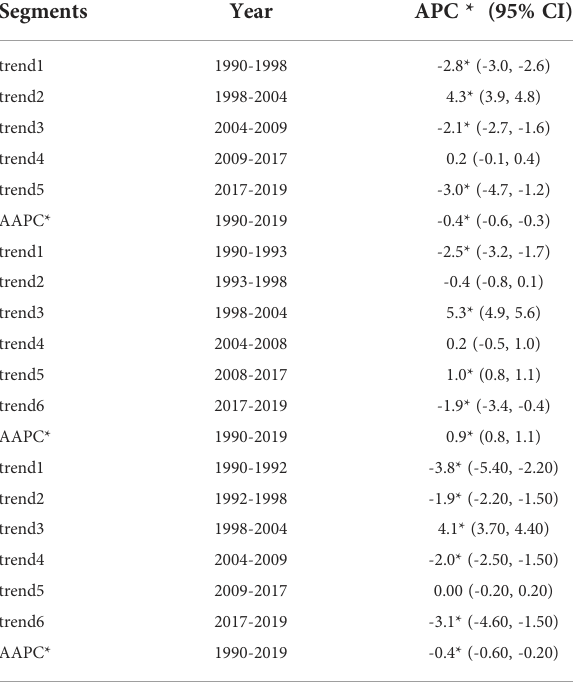
TABLE 1 Trends in cervical cancer incidence, mortality and DALY rates in China, 1990 –